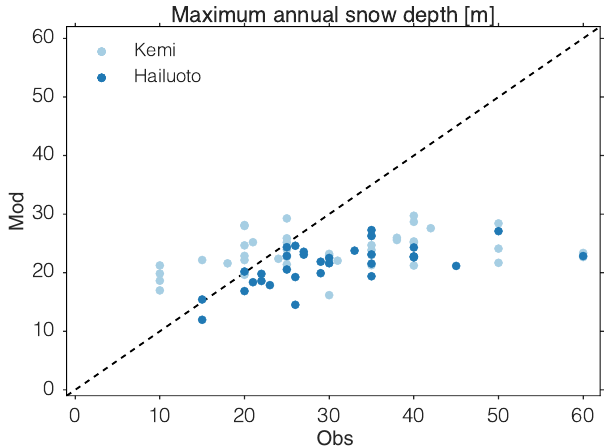
Figure 3. Comparison between observed and simulated maximum annual snow depths at two stations (Kemi and Hailuto; see Fig. 1) in the Bothnian Bay. Observed snow depths are on the x -axis and NEMO-Nordic snow depths on the y -axis. The Hailuoto station covers the period 1974–2006 and the Kemi station the period 1961– 2005.